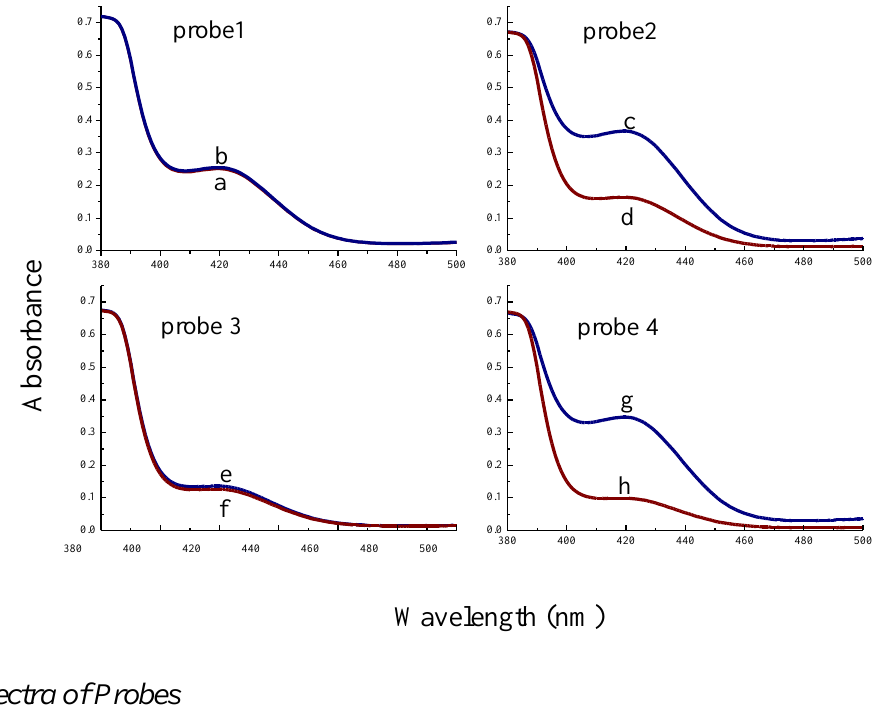
Figure 2. Absorbance spectra of the H ( a ) probe-1 (1.0 × 10 −7 mol·L −1 ); ( b ) probe-1 (1.0 × 10 −7 mol·L −1 ),